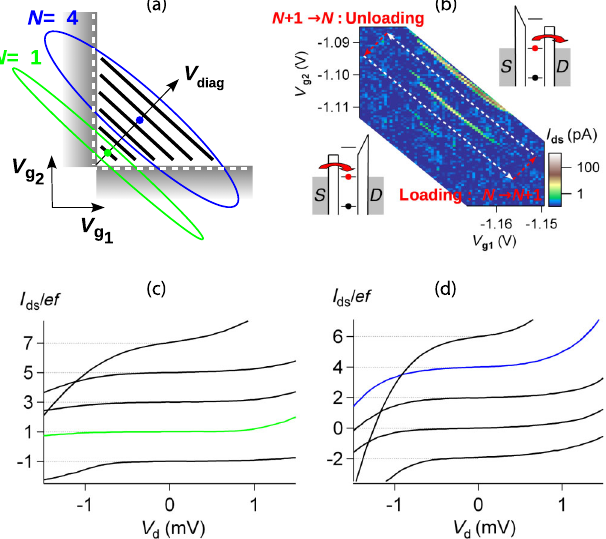
FIG. 3. (a) Schematics of pumping contours realized with phase-shifted rf signals on the two gates. Increasing the shift results in wider ellipses that enclose several Coulomb segments of the island (1 and 4 in the examples drawn in green and blue). The white dashed lines and shaded regions indicate the onset of versus V conduction, respectively, through gates 1 and 2. (b) I ds g1 and V in sample s 2 at 0.5 K. The dashed lines indicate the four g2 sequences of electron pumping. For the white lines, the potential of the island is kept constant, hence its population as well. The two red ones cross the Coulomb line and therefore require a population change N $ N þ 1 . As is sketched, such transitions involving a population change happen when one of the two FIG. 2. Drain-source current I for a small drain bias of barriers is very high, forcing electron transfer to occur through ds 50 (cid:3) V at 0.5 K (sample s 1 ). (a) 2D plot versus both gate =ef versus drain bias V the other one. (c) Normalized current I ds d voltages, showing the pattern of segments due to the island for ellipses at f ¼ 54 MHz centered near a Coulomb line, of is that is capacitively coupled to both gates. The axis V equal amplitude on both gates ( (cid:2) 26 : 5 dBm ) but of different diag defined by passing through the middle of the Coulomb segments. phase shifts. Plateaus at odd numbers of electrons are found at ¼ 0 : 8 V . The steep subthreshold slope versus V for V (b) I 1 K, since a growing but always odd number of lines is ds g1 g2 over several decades illustrates the quality of the barrier below surrounded as the ellipses get wider. (d) Even plateaus obtained . The numerical values corre- gate 1. (c) Cut of (a) along V for ellipses centered in between two Coulomb lines and therefore diag spond to the projection on the V axis. enclosing an even number of g2